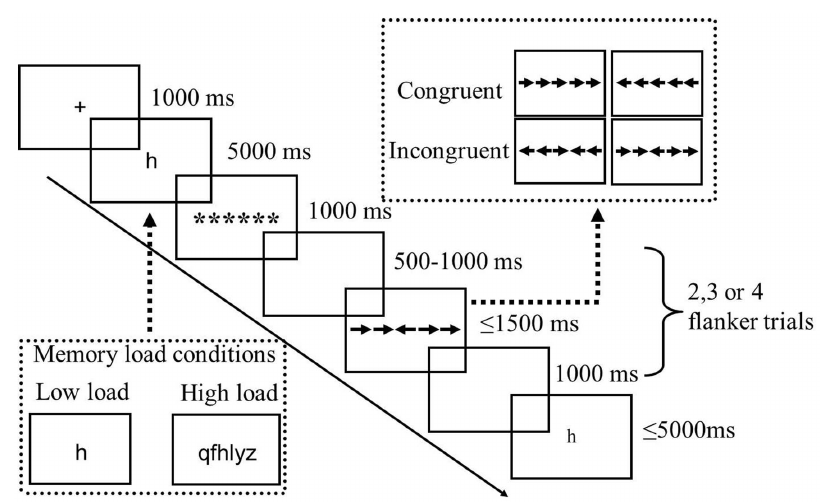
Figure 1. Procedure used in the present experiment, showing an incongruent trial under low working memory load.